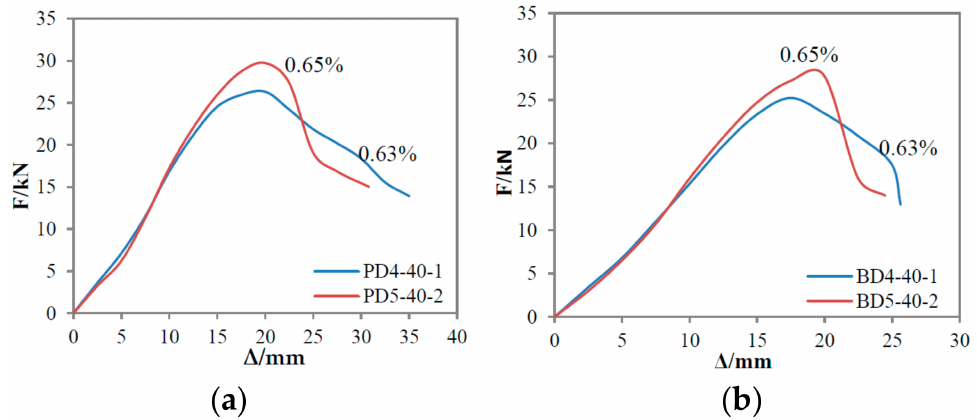
Figure 10. Influence of reinforcement ratio on bearing capacity of specimens. ( a ) Ordinary concrete wallboard with different reinforced form; ( b ) Recycled concrete wallboard with different reinforced form.